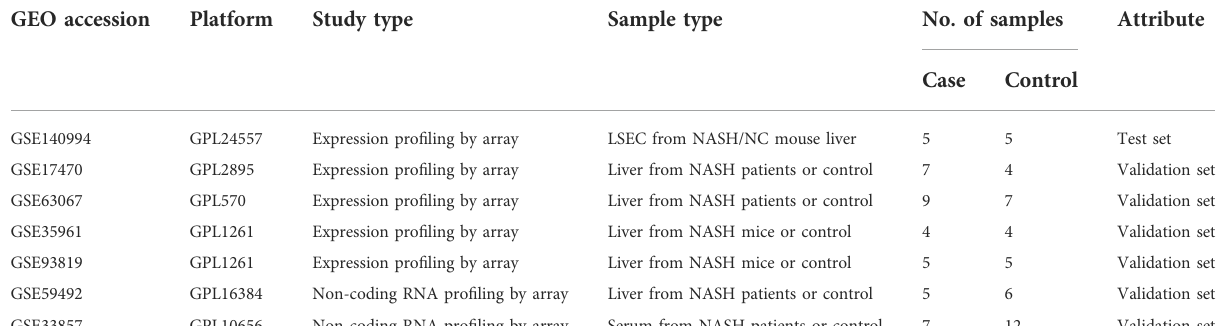
TABLE 1 Information of selected GEO